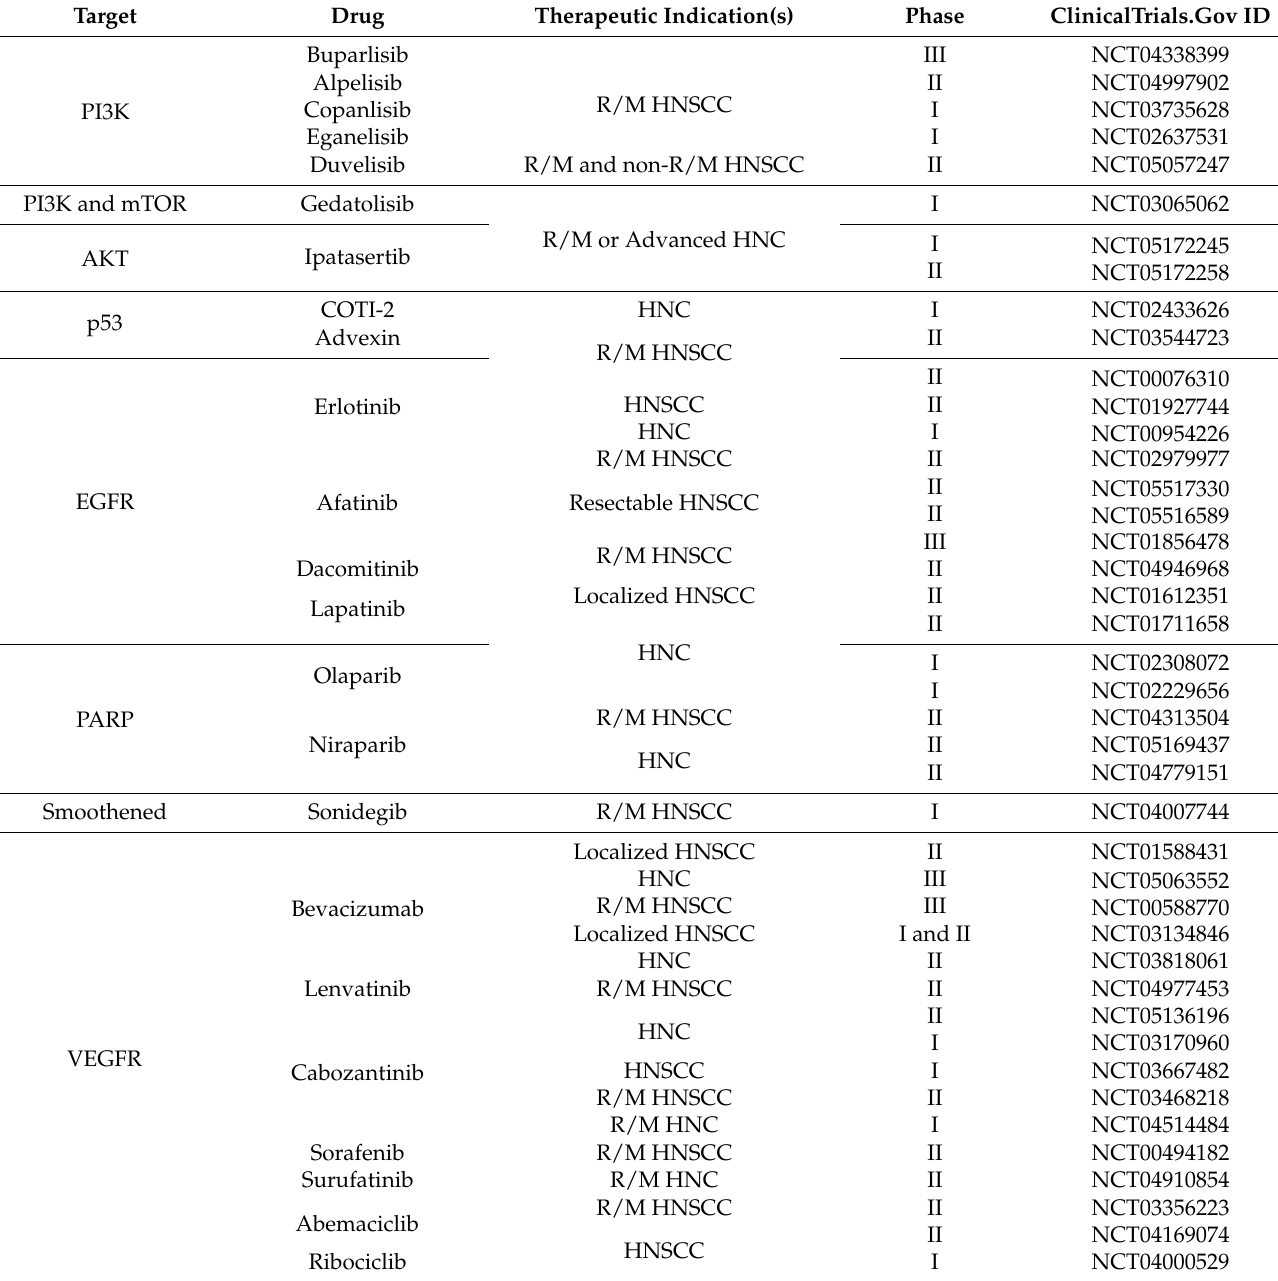
Table 4. Examples of different targeted therapies in clinical trials for HNC and respective